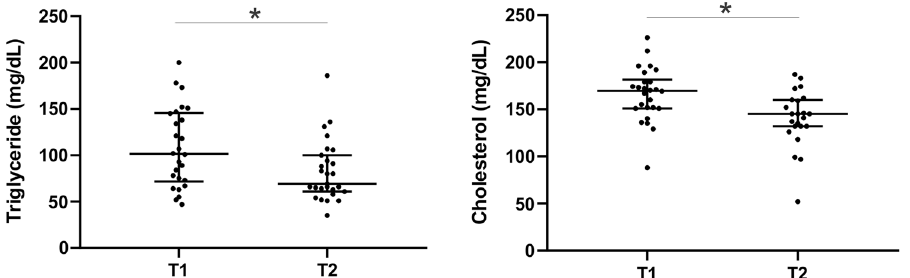
Figure 3. Triglycerides and cholesterol levels at the time of bariatric surgery (T1) and after (T2) the procedure. * p ≤ 0.05 T1 vs. T2. Mann Whitney test and Dunn’s multiple comparisons